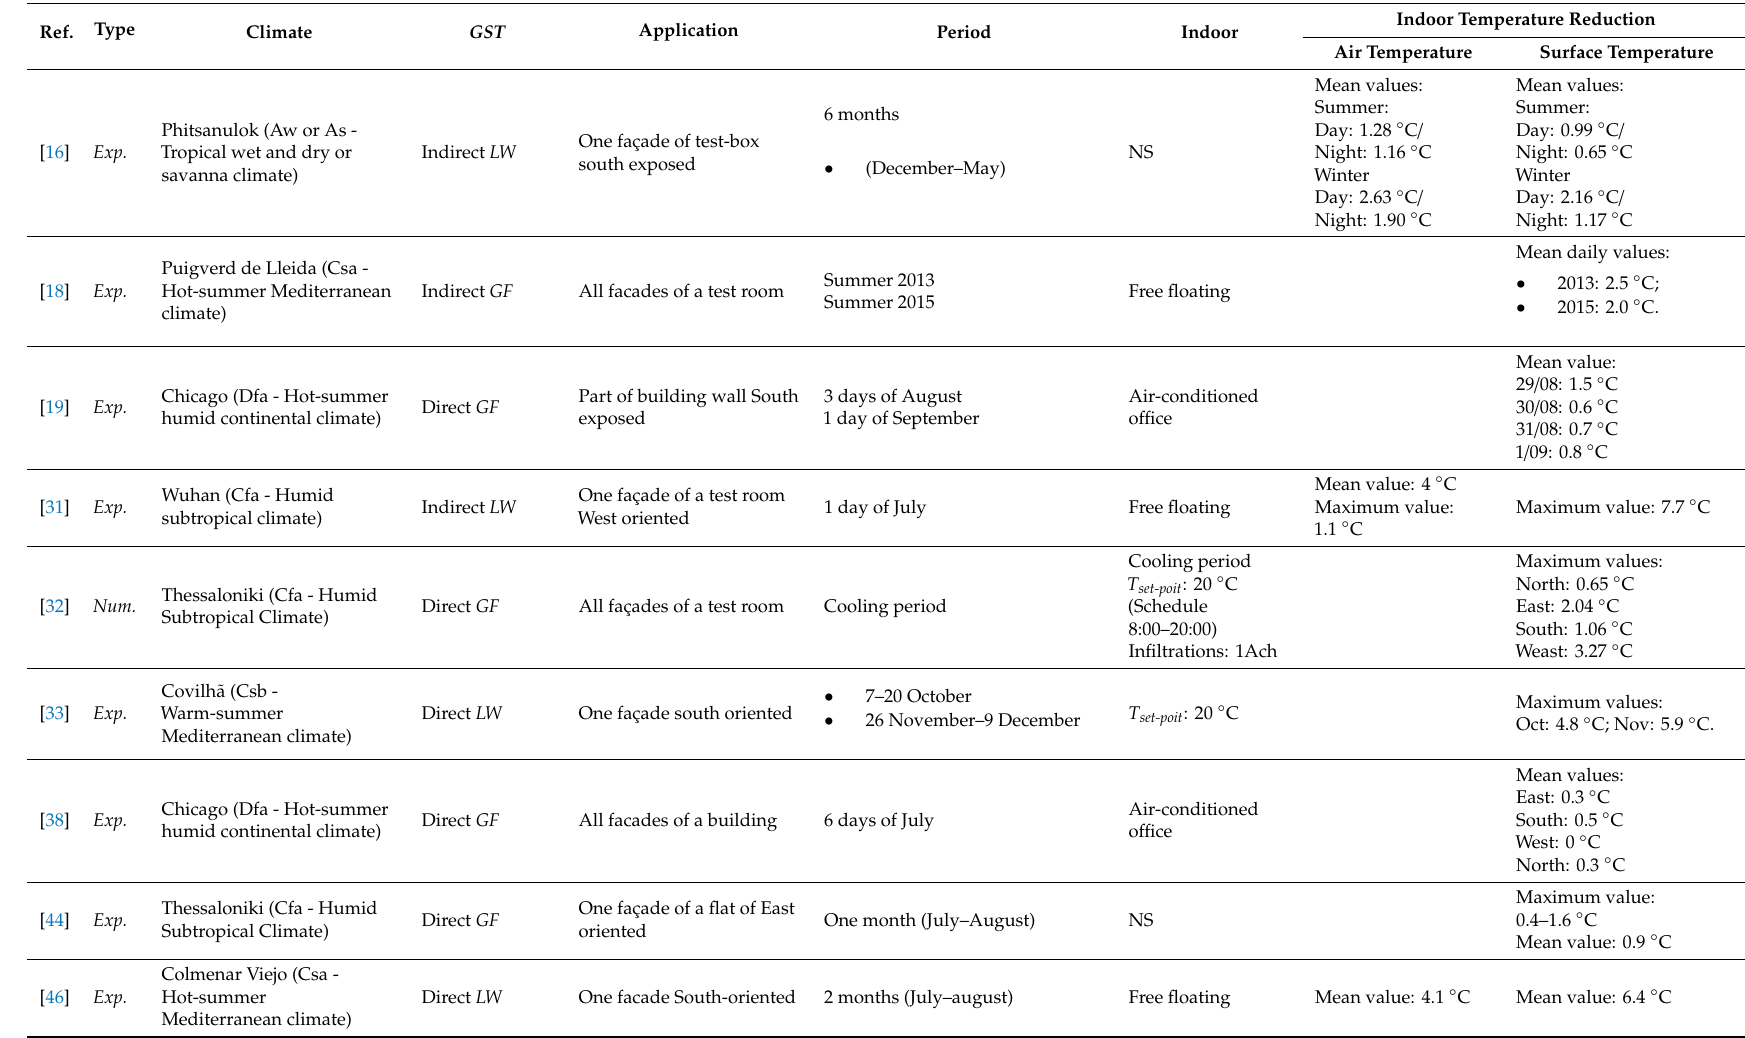
Table 5. Results indoor thermal